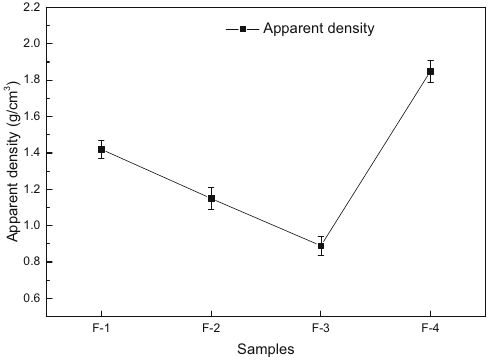
Figure 10: Apparent density of composites.